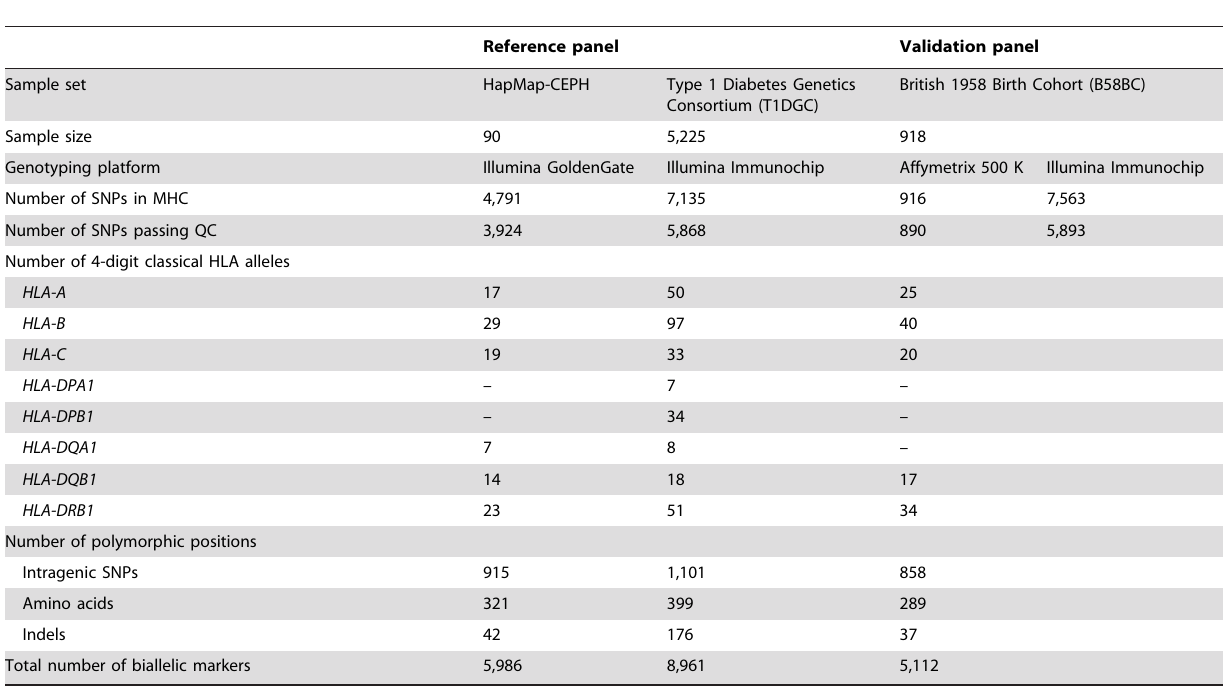
Table 1. Overview of the HapMap-CEPH and T1DGC reference panels and the B58BC validation panel.